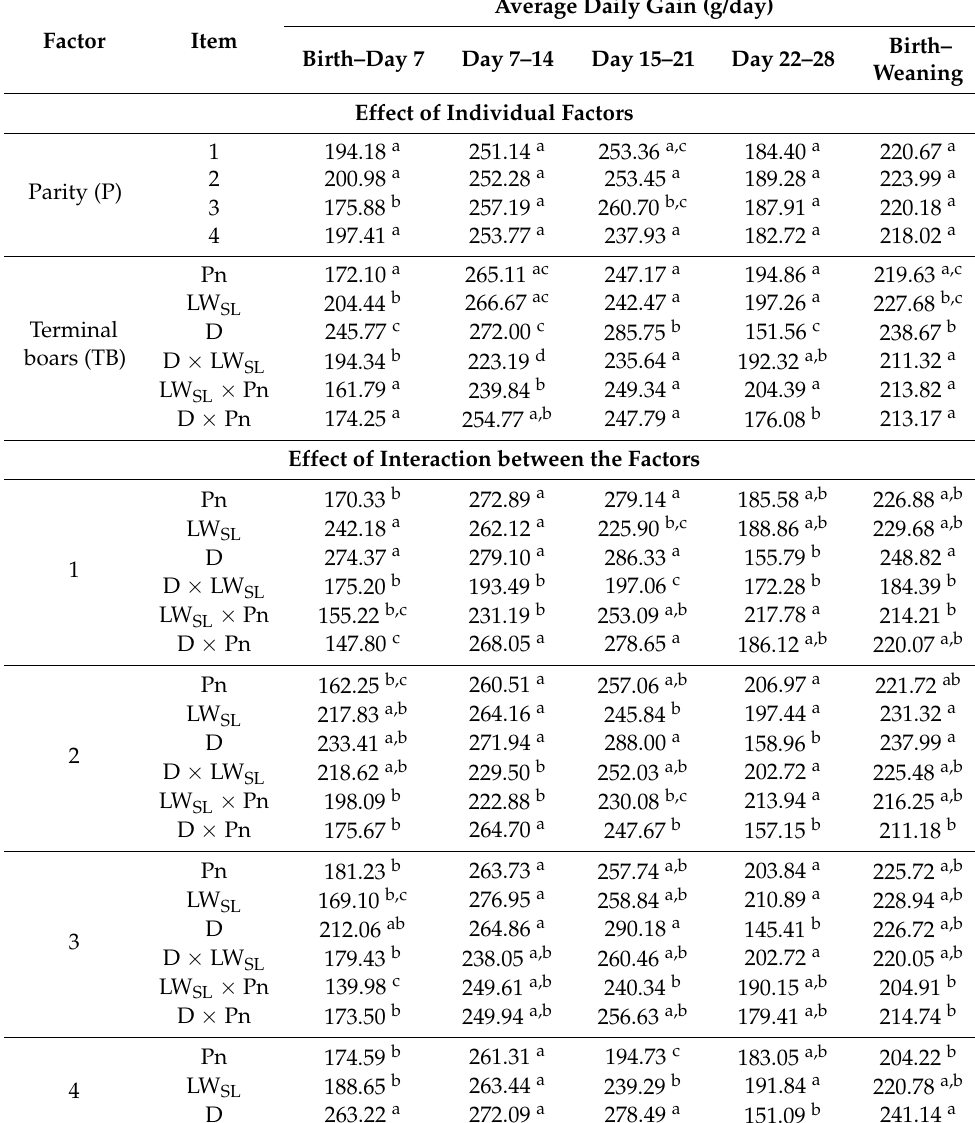
Table 6. The effect of terminal boar and parity of sows on average daily gain of